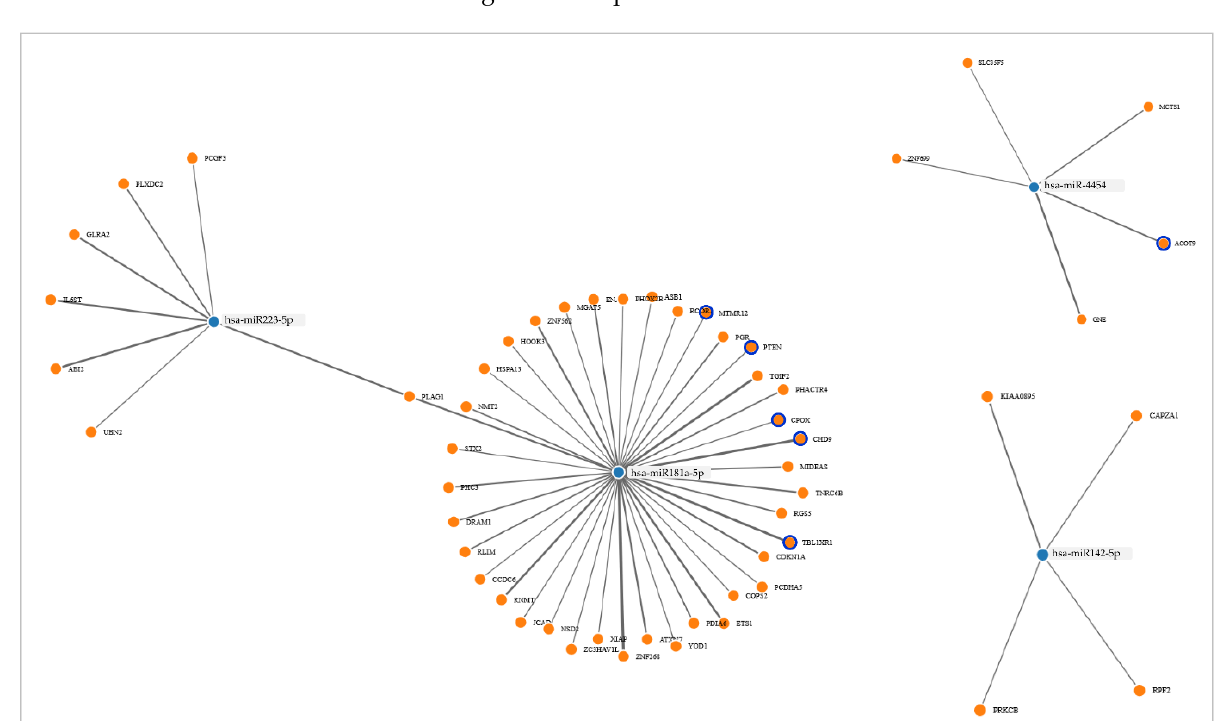
Figure 5. Network graph plot. The miRNA-target gene interactions are displayed as a node graph. Blue rings show miRNA – target genes associated with lipid metabolism.